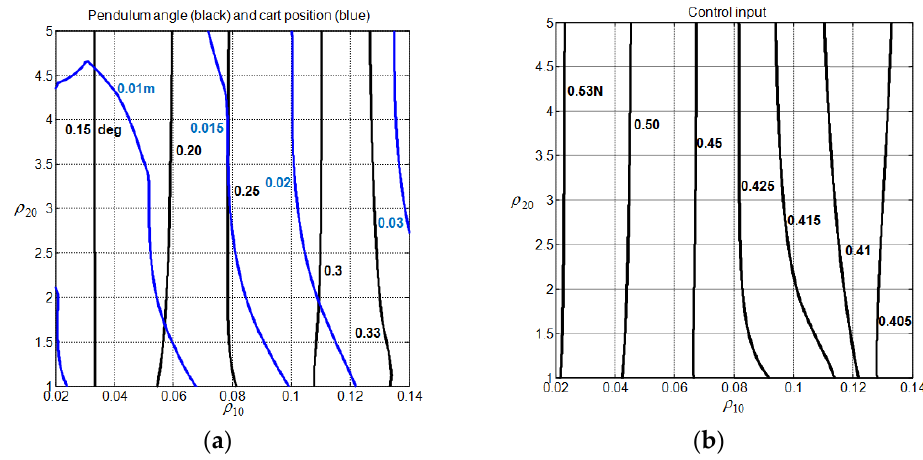
Figure 17. CIP steady-state performance with a disturbance input using SIM controllers. ( a ) Maxi- mum absolute values of the pendulum angle and cart position; ( b ) maximum absolute values of the control input signal.